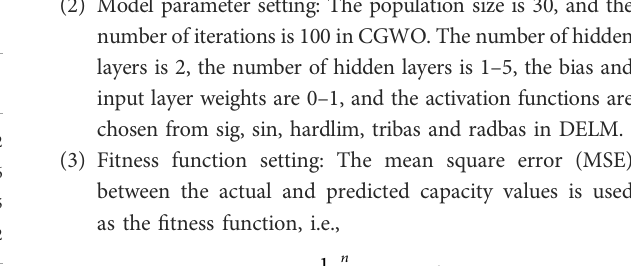
TABLE 2 Correlation